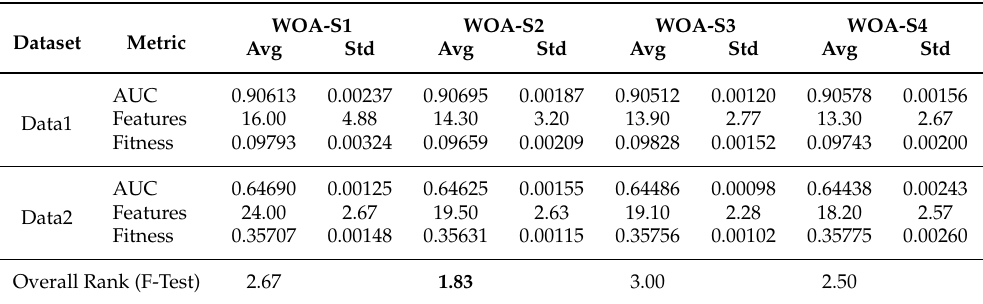
Table 9. Evaluation results of WOA using four S-shaped TFs in terms of average and standard deviation of AUC, No. selected features, and fitness values.